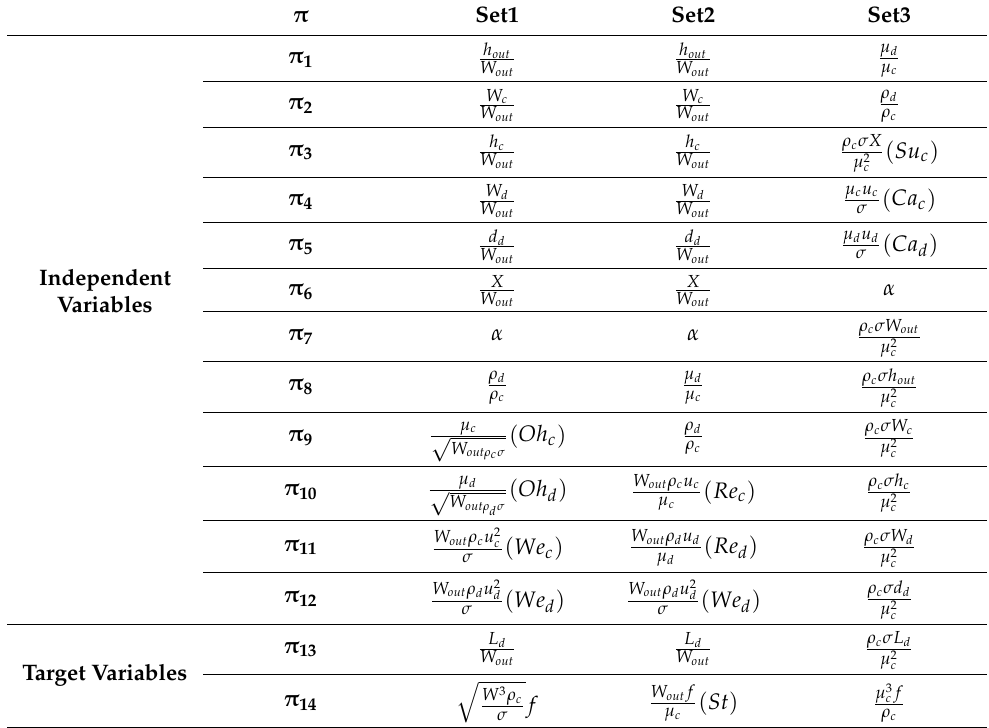
Table 2. Three typical solutions of dimensionless numbers ( π